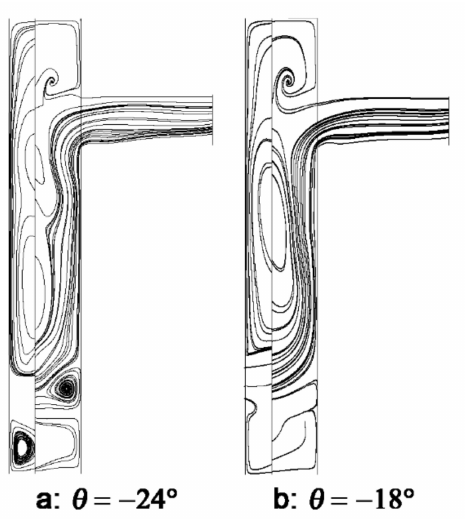
Figure 16. Streamline at plane θ = − 12 ◦ for different gap ratios: ( a ) G = 0.0231, ( b ) G = 0.0370, ( c ) G = 0.0509, ( d ) G = 0.0648.